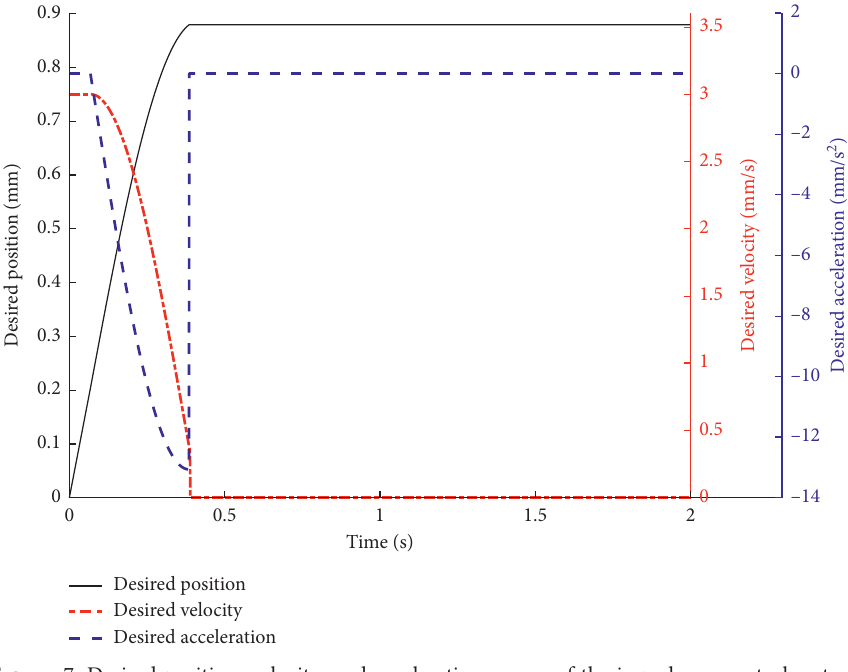
Figure 7: Desired position, velocity, and acceleration curves of the impedance control system.